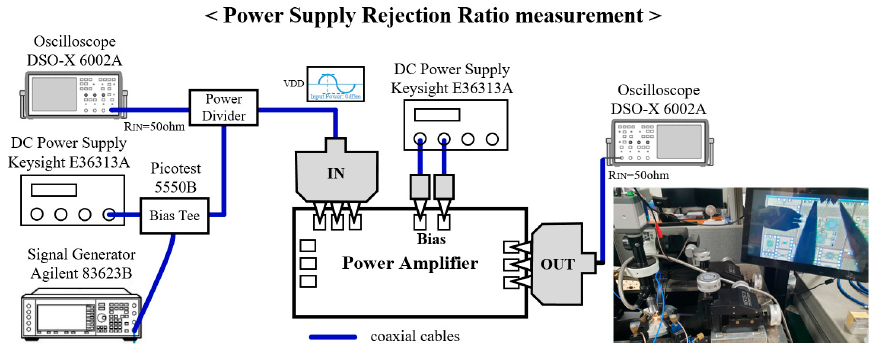
Figure 10. The PSRR measurement setup.